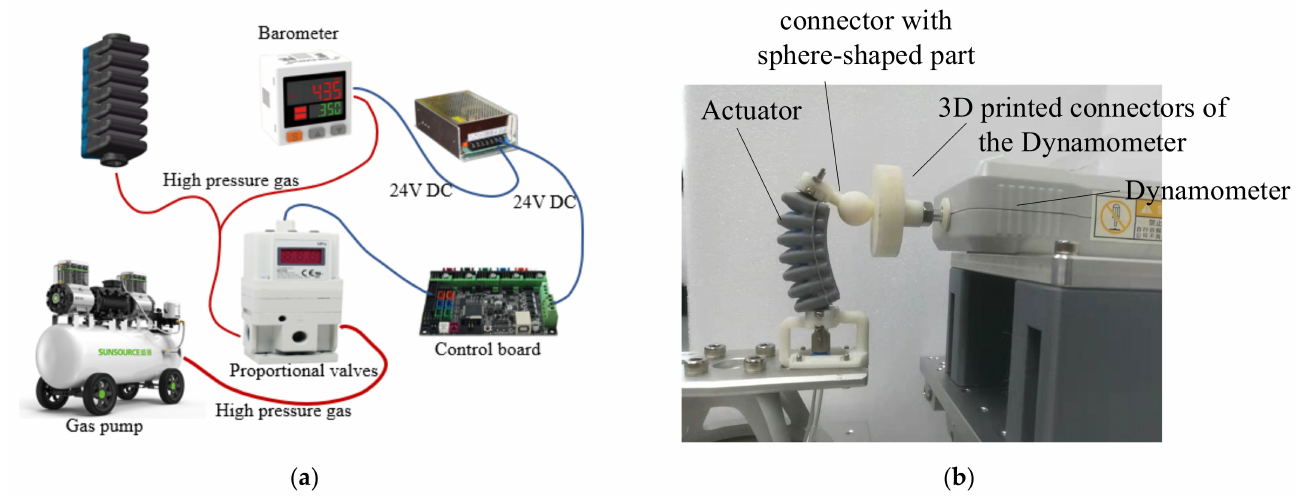
Figure 7. The test platform and experimental settings for measuring tip force: ( a ) The established test platform, the air pump is not shown. ( b ) Experimental settings for measuring tip force of the